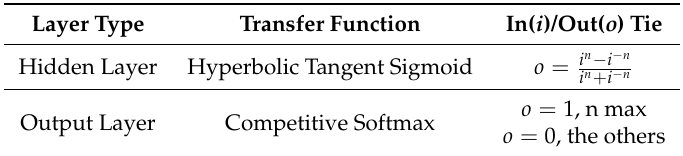
Table 1. Transfer functions used to solve classification problems with ANN expert systems for IMs fault